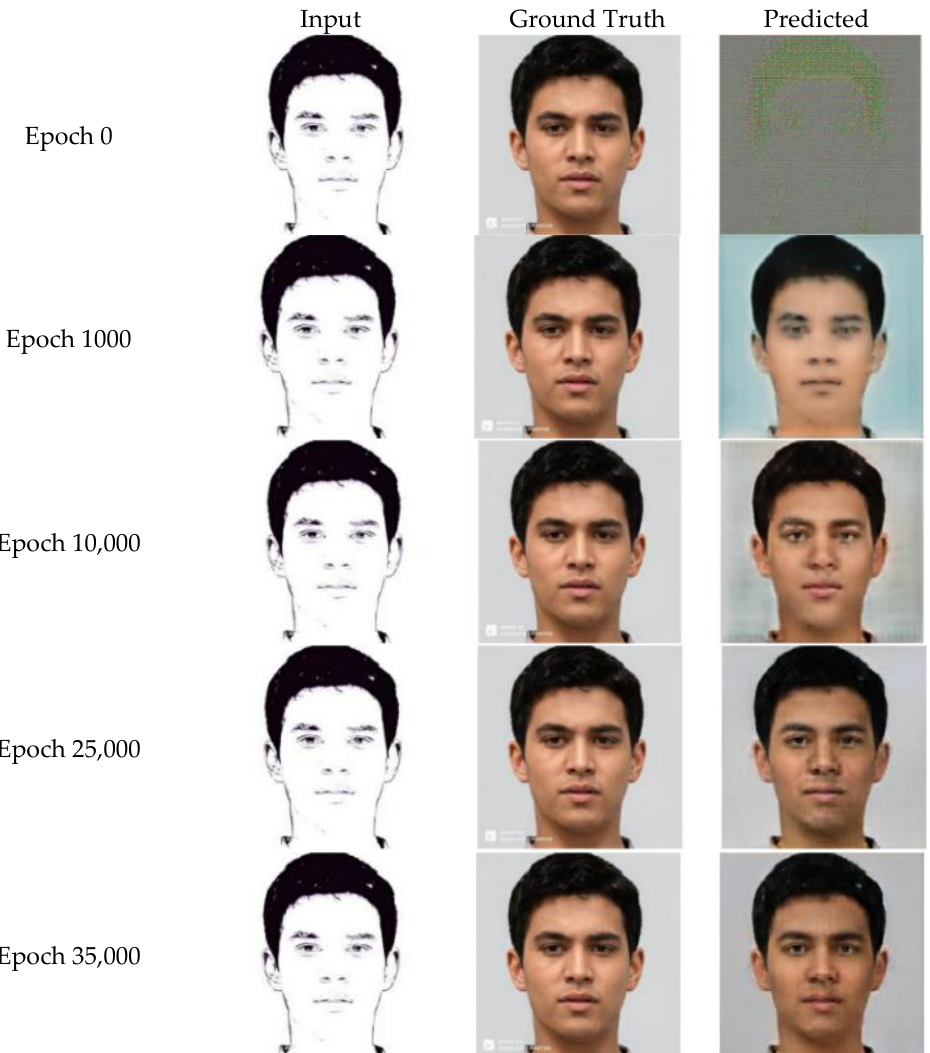
Figure 12. Generated images of increasing epoch show the improvement of the visual quality. (ground truth images by generated photos